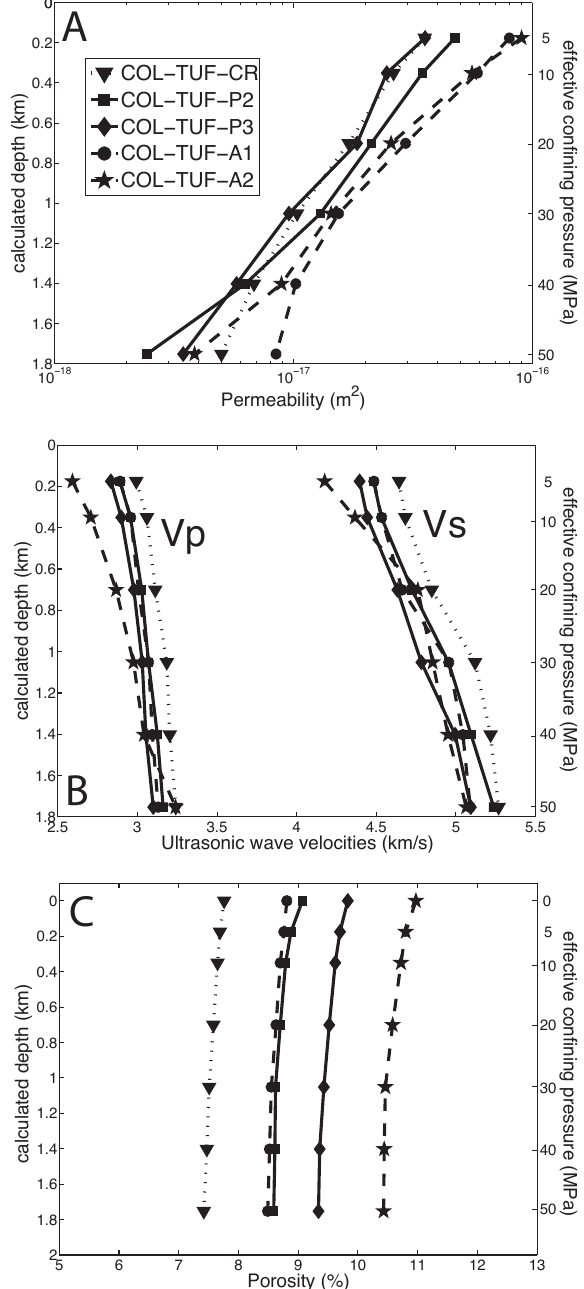
Fig. 3. (A) Depth and effective confining pressure vs. log of per- meability showing a similar evolution for all samples over depth. At depths shallower than 1km the permeability for samples with tuffisite veins oriented at 45 degrees to flow doubles relative to the samples with tuffisite veins oriented perpendicular to flow. (B) Depth and effective confining pressure vs. ultrasonic wave veloc- ities showing similar evolution of both V p and V s with depth for all samples. (C) Depth and effective confining pressure vs. porosity showing similar evolution of porosity with increasing depth for all